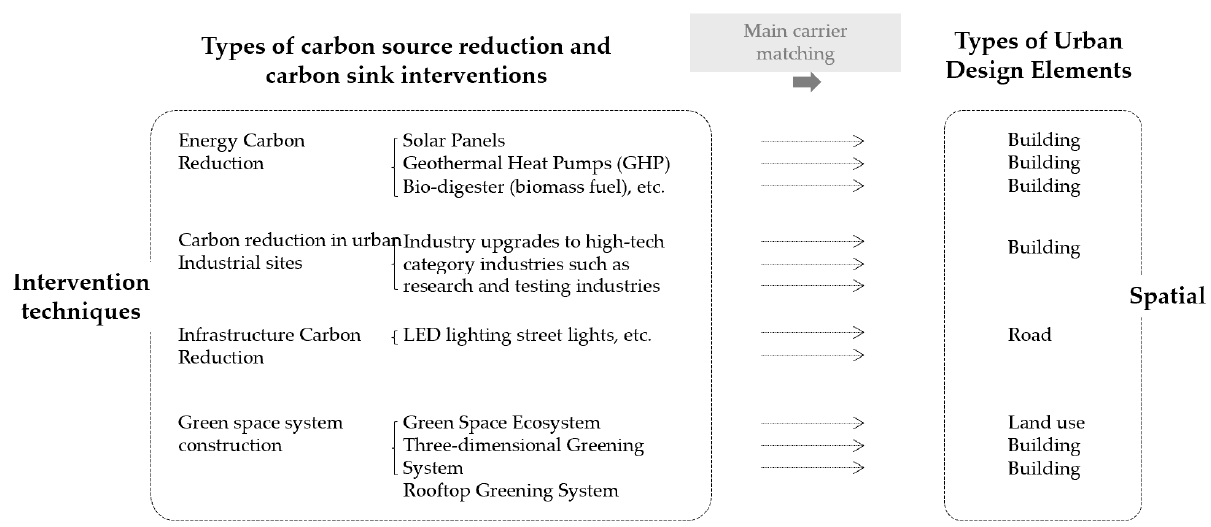
Figure 6. Matching carbon reduction and carbon sink approaches with urban design elements.